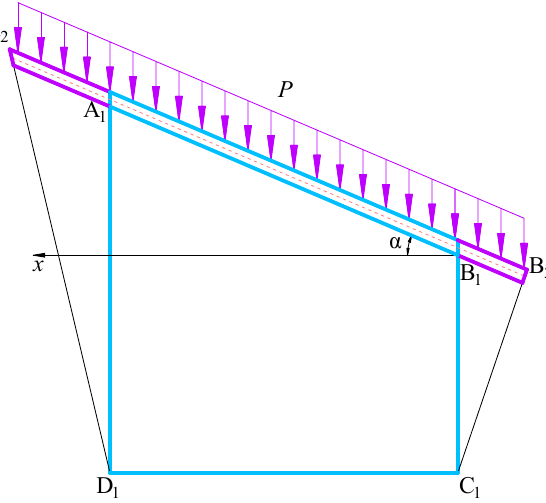
Figure 14. Mechanical model of roadway cyclic deformation and failure.